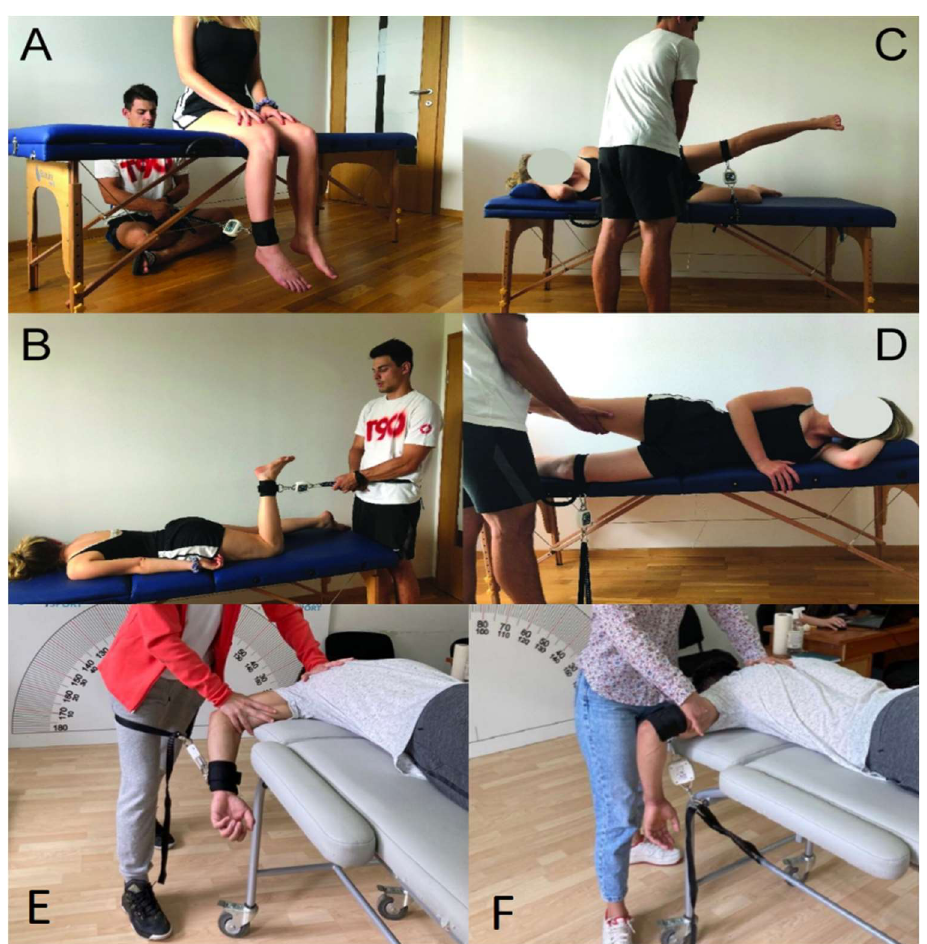
Figure 2. The positions for EasyForce measurements for knee extension ( A ), knee flexion ( B ), hip abduction ( C ), hip adduction ( D ), shoulder internal rotation ( E ), and shoulder abduction ( F ).